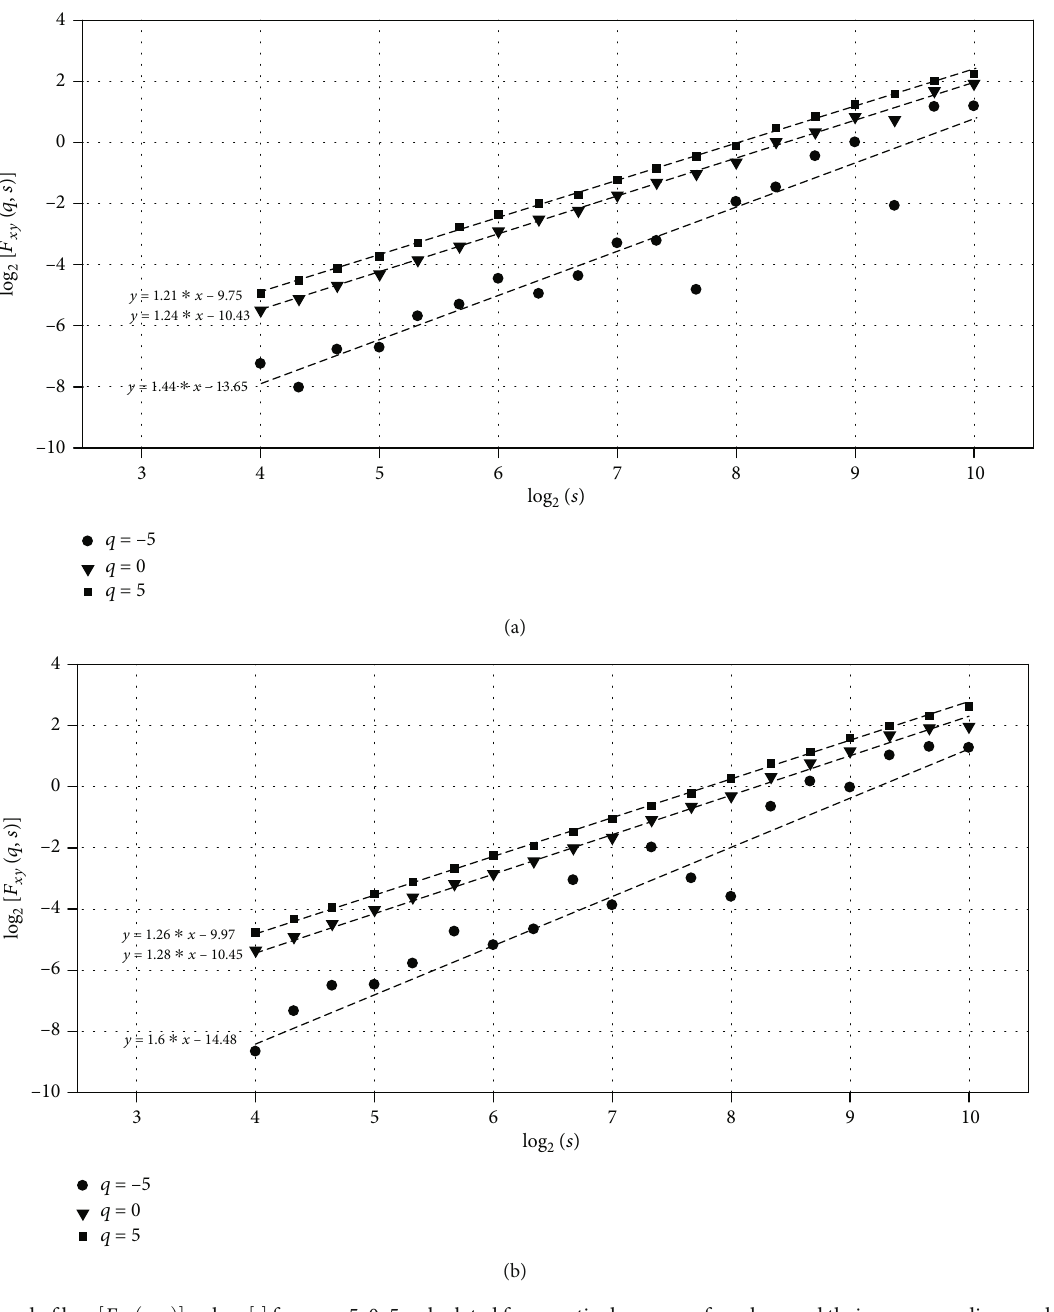
Figure 7: Trend of log ½ F xy ð q , s Þ(cid:2) vs log ½ s (cid:2) for q = − 5, 0, 5 , calculated for a particular range of η values and their corresponding φ values for (a) 2 2 8TeV dataset and (b) 7TeV